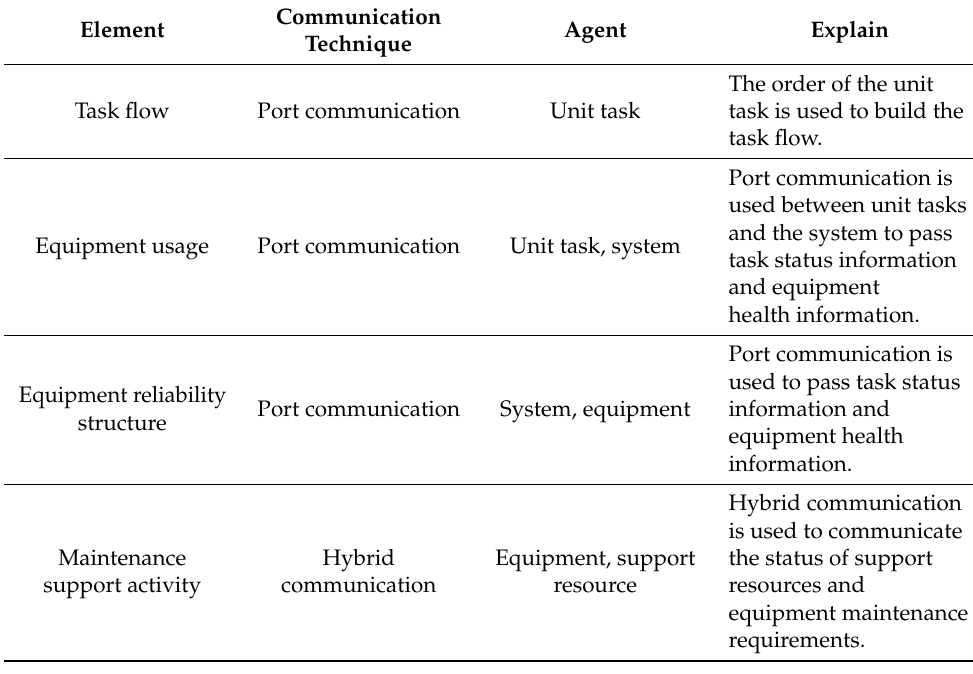
Table 2. Element simulation scheme.